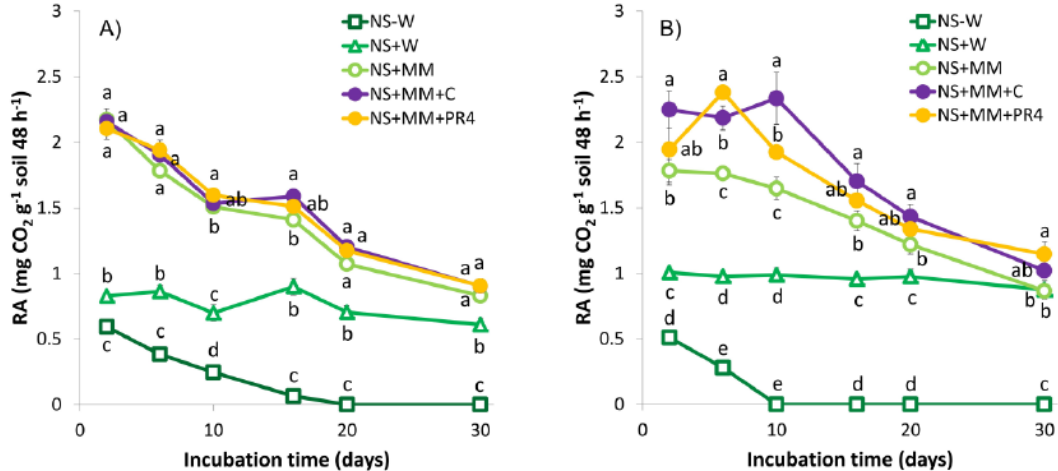
Figure 4. Respiration activity (RA) in soil microcosms over 30 days, when applying a ( A ) smaller and a ( B ) larger size of inoculum for bioaugmentation. Different letters in the same remediation time indicate statistical differences among treatments ( n = 3, p ≤ 0.05).